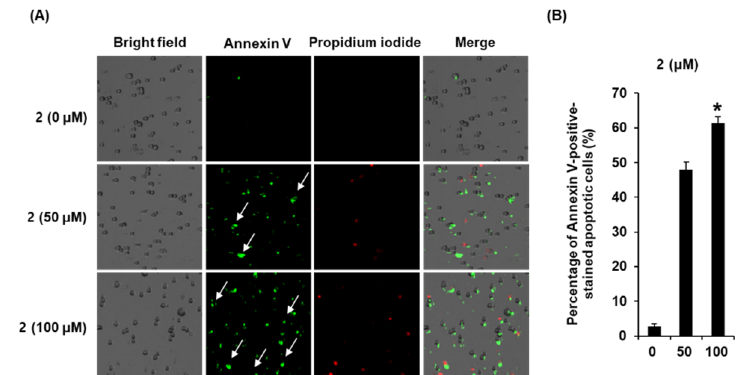
Figure 5. E ff ects of aviculin ( 2 ) on apoptotic cell death in MCF-7 human breast cancer cells. ( A ) Representative images of apoptotic cells stained with annexin V (green) and propidium iodide (red). ( B ) Percentage of annexin V-positive apoptotic cells. Control cells were treated with 0.5% DMSO. The same number of cells for the control and sample were stained and analyzed. Ten di ff erent fields (40 × magnification) per slide were taken with Tali Image-Based Cytometer and representative fields for each condition are shown. The experiment was performed in triplicate, and the error bars represent the standard deviation of samples ( n = 3). * p < 0.05 compared with the control.